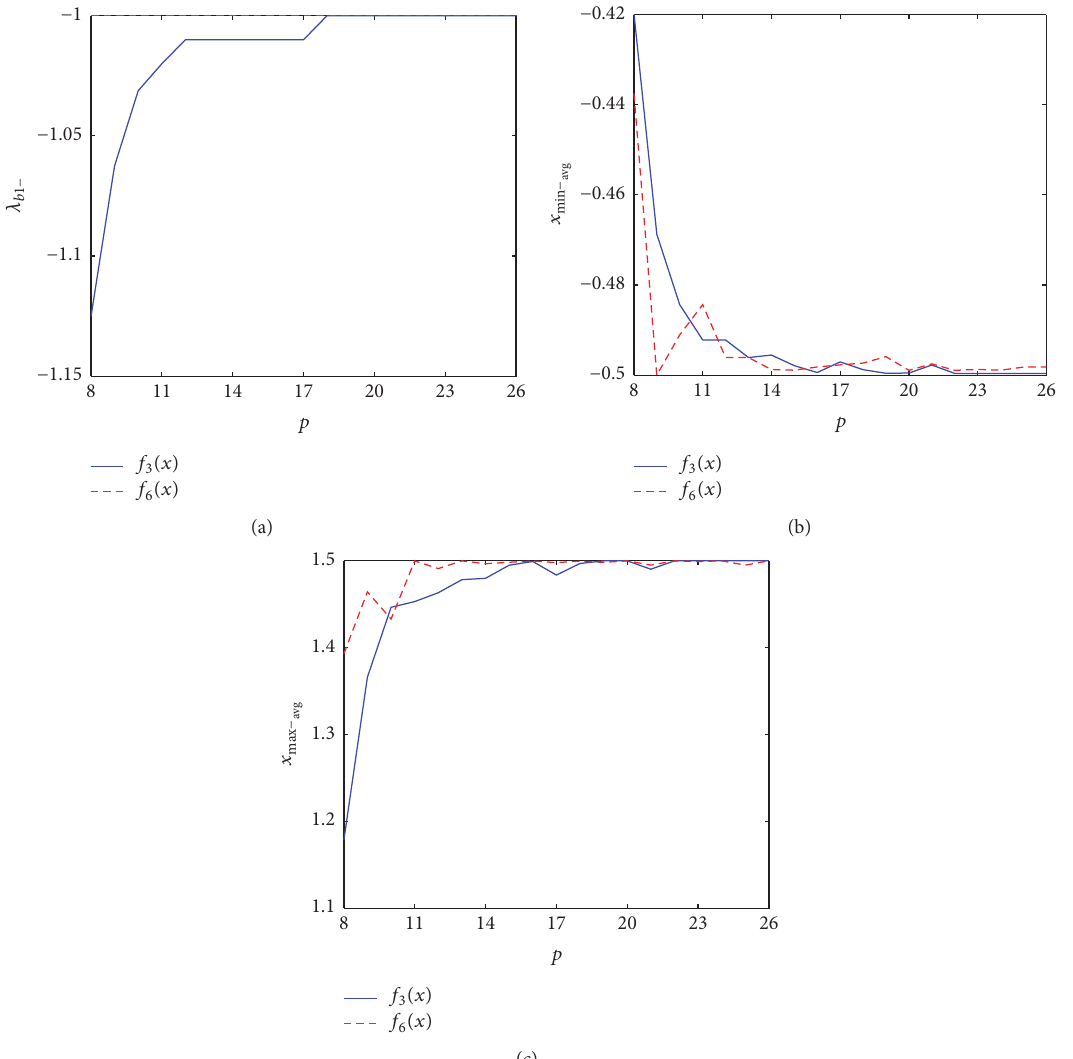
Figure 8: The key-points of the bifurcation diagram for the two negative control parameter map versions 𝑓 3 (𝑥) and 𝑓 6 (𝑥) at different precisions. (a) The first bifurcation point. (b) The average minimum value. (c) The average maximum